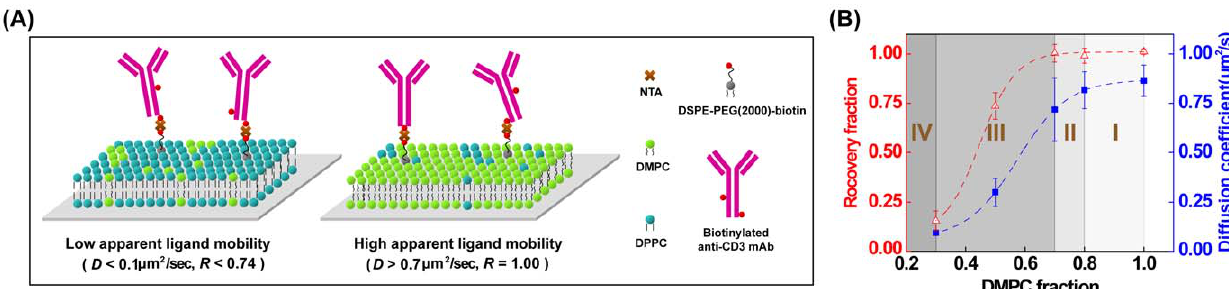
Figure 1. A variety of membrane fluidities and heterogeneities on the binary mixture of lipid bilayers. (A) Schematic illustration of self- assembled supported lipid bilayers containing a mixture of DMPC, DPPC, and 2% DSPE-PEG2000-biotin. Biotinylated anti-CD3 monoclonal antibody was anchored to bilayer surfaces via neutravidin (NTA). (B) The diffusion coefficient D (blue solid squares) and mobile fraction R (red open triangles) of NTA were determined by curve-fitting to the traces of fluorescence recovery after photobleaching at 37 u C. The graph was further divided into four regions: I, fluid phase region; II, fluid-connected region; III, fluid-confined region; and IV, low mobility region. Dashed lines are sigmoidal curve fits to guide the eye. Error bars represent the standard error of the mean. N . 6 FRAP measurements.